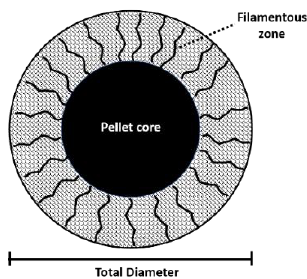
Figure 11. Pellet measurement including core diameter, total diameter, and length of filaments. Measurements were performed using ImageJ software.